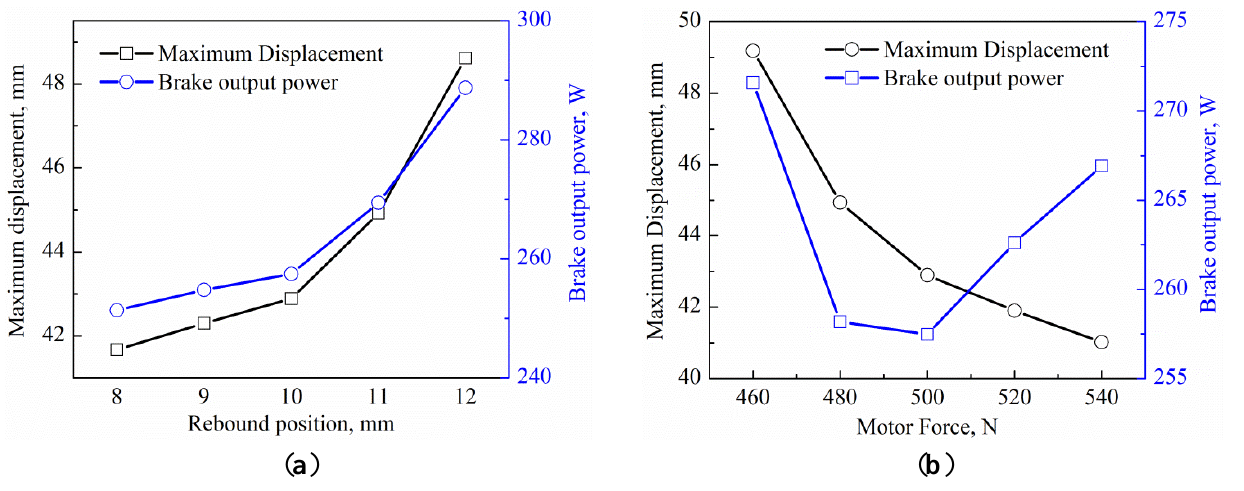
Figure 5. ( a ) Maximum displacements and brake output power of the linear generator at different motor forces; ( b ) Maximum displacements and brake output power of the linear generator at different rebound